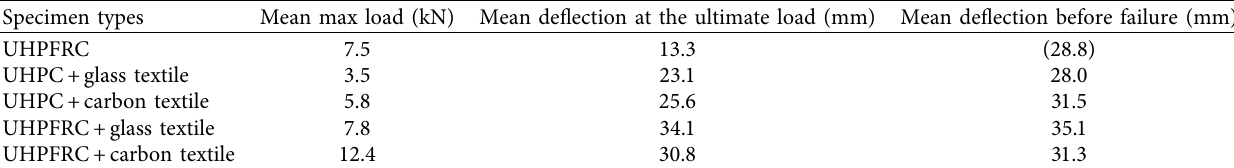
Table 5: Key values of the load-deflection